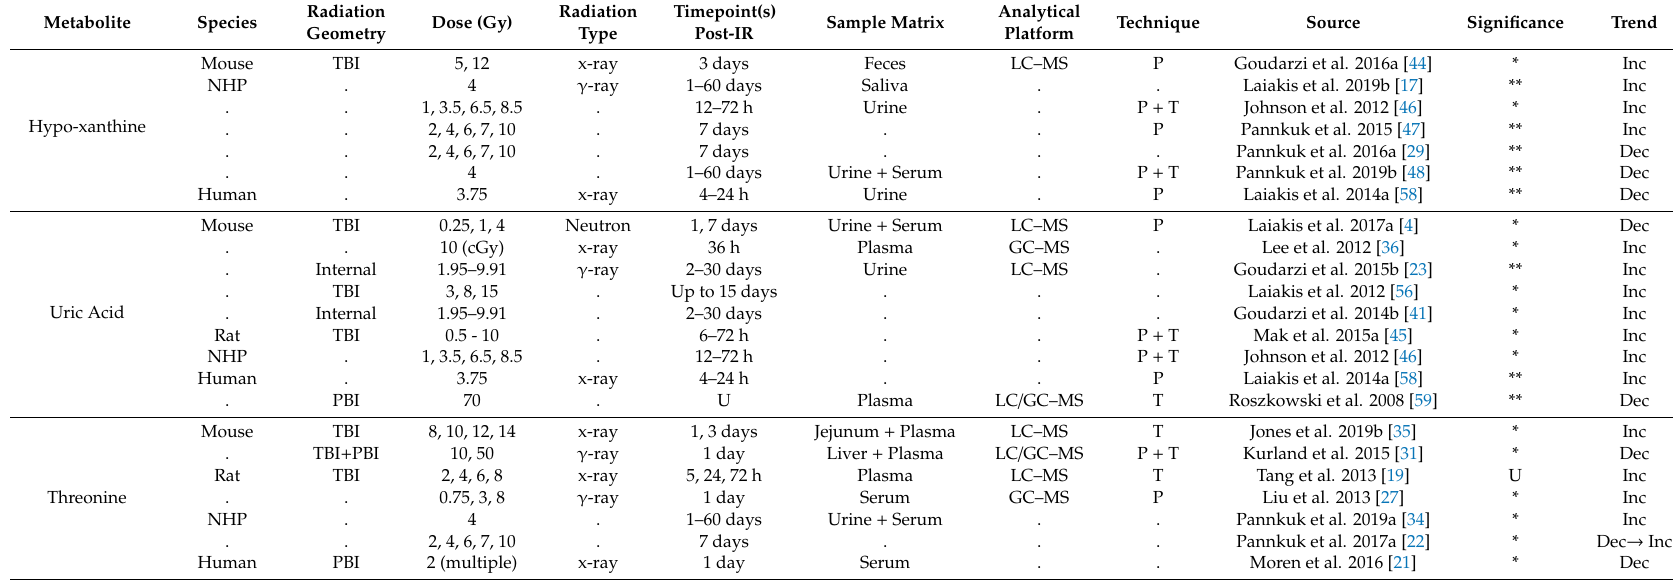
Serum . . Moren et al. 2016 [21] * Dec Table 1 abbreviations and key: Species: NHP (Non-Human Primate). Radiation Geometry : TBI (Total Body Irradiation), PBI (Partial Body Irradiation). Analytical Platform : LC-MS (liquid chromatography mass spectrometry), 1 H NMR (hydrogen-1 nuclear magnetic resonance), GC-MS (gas chromatography mass spectrometry), DMS-MS (Di ff erential mobility spectrometry mass spectrometry). Technique : Metabolite identification technique P (global profiling), or T (targeted). Significance : * p -value ≤ 0.05, ** p -value ≤ 0.001 in at least one parameter when comparing sham or pre- versus post-IR, NS (No significance). Trend : Inc (increase), Dec (decrease), or V (variable) is comparing sham or pre- to post-IR. All columns : U (Unknown). Any spaces designated with a point (.) indicates the parameter is identical to the information provided